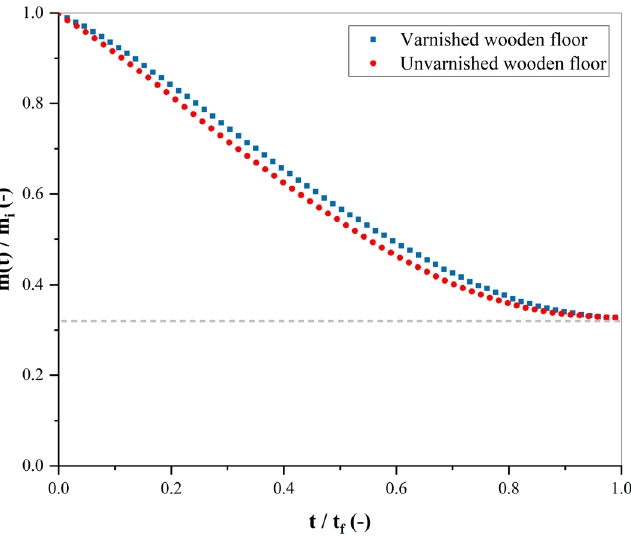
Figure 4. Drying kinetics of a blood pool ( m i = 4.83 g , hct = 41.5% ) on varnished (blue) and unvarnished (red) wooden floors at 21 ◦ C with a relative humidity of 60%. The gray line represents the final ration m f / m i = 32.3%. (OriginPro 2018).